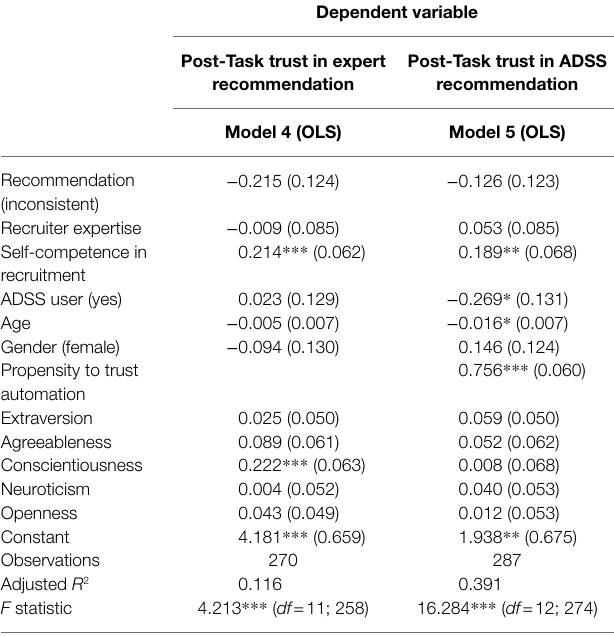
TABLE 2 | Trust perceptions according to the source of